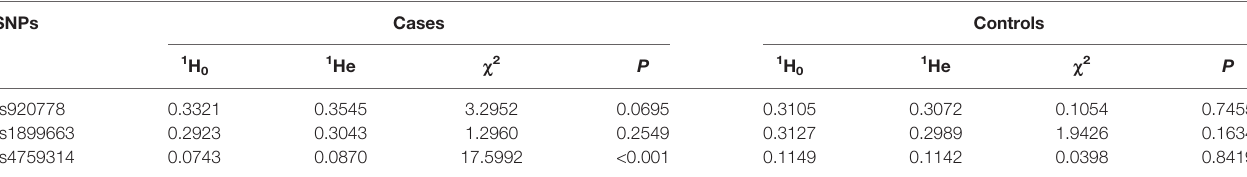
TABLE 2 | Hardy-Weinberg equilibrium test for different HOTAIR SNPs. SNPs Cases